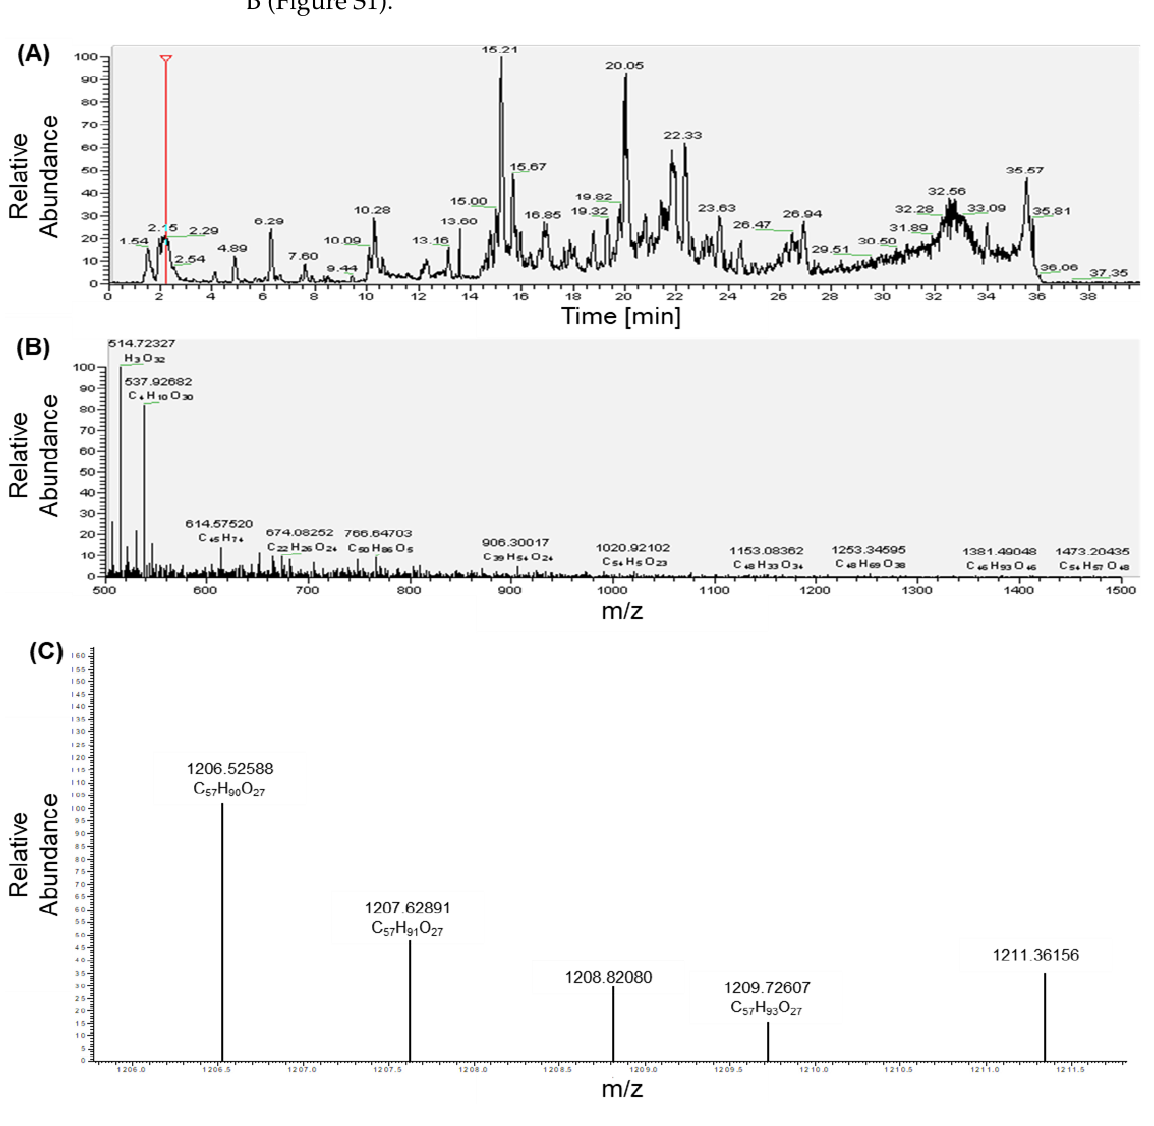
Figure 1. LC/TOF-MS analysis of the isolated saponins. ( A ) The LC/MS chromatogram of the saponin fraction isolated from green tea seed ethanolic extracts. ( B ) The MS of the saponin fraction isolated from green tea seed ethanolic extracts. ( C ) The NMR of the saponins detected and identified in the saponin fraction purified from green tea seed ethanolic extracts.